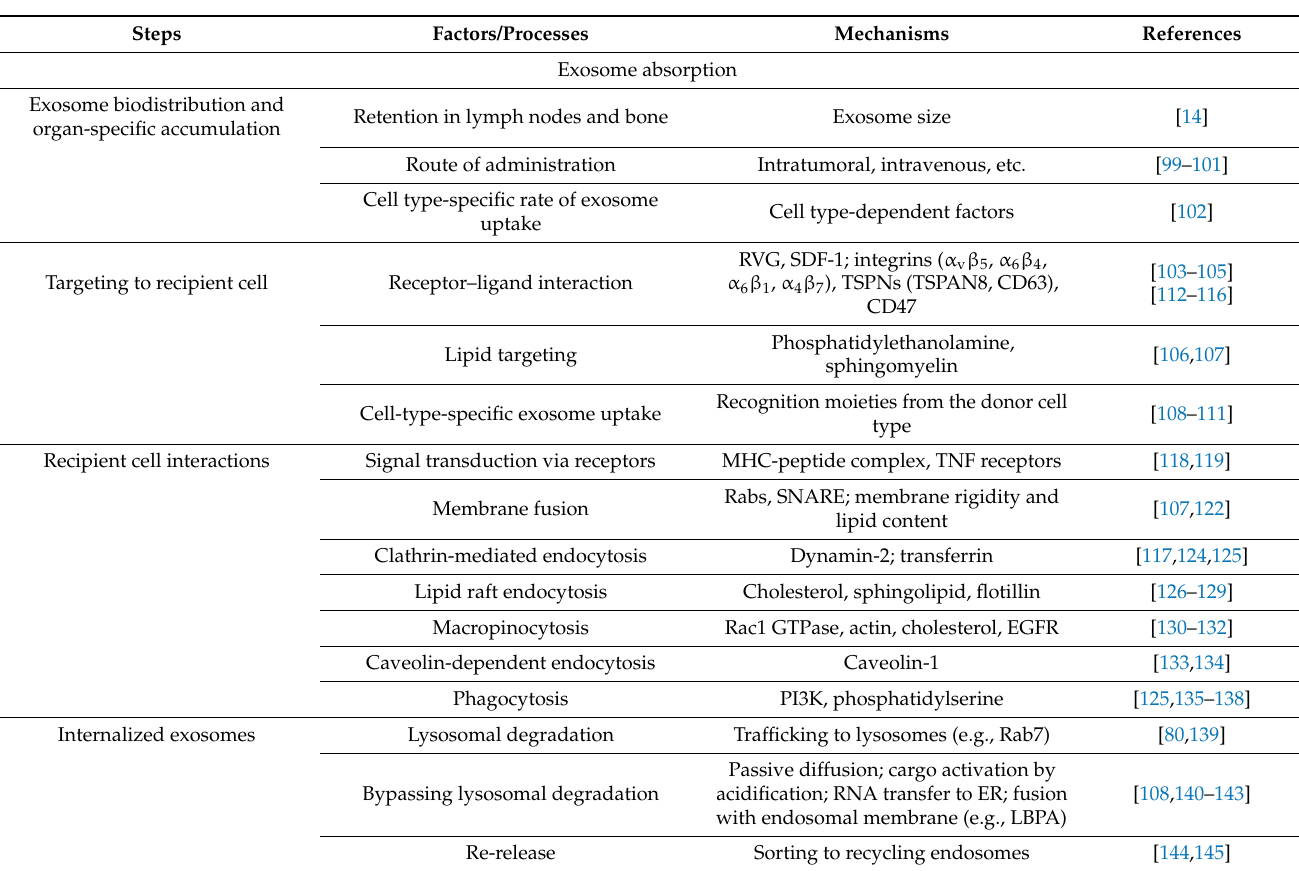
Table 2. Steps in exosome absorption and associated